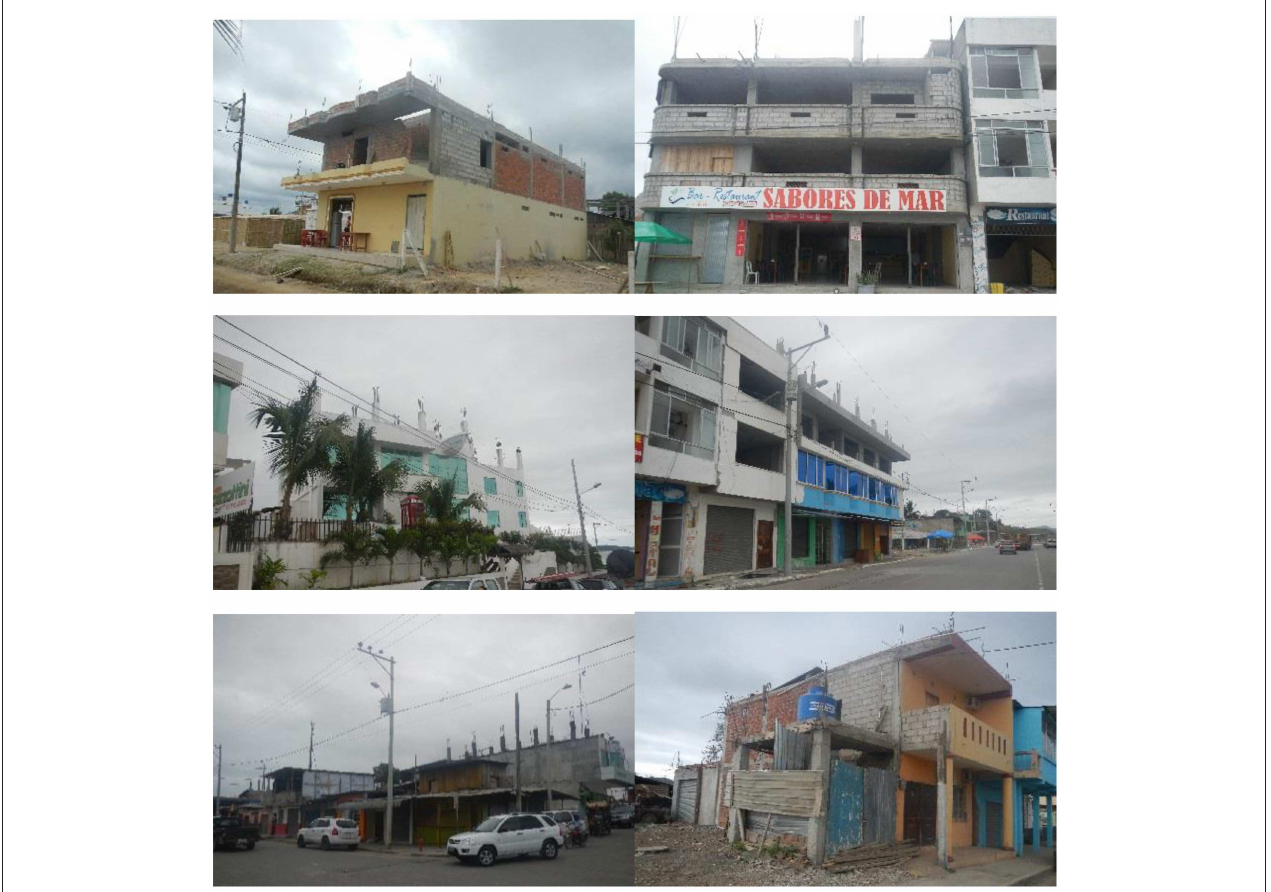
FIGURE 9 | Exposed reinforcement for future extension of building observed in various affected towns in